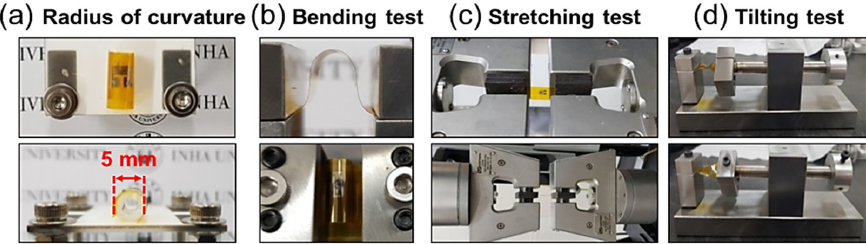
Figure 29. Digital photographs showing the ( a ) radius of curvature, ( b ) bending test, ( c ) stretching tests, and ( d ) tilting test. Reproduced from [107] with the permission of Elsevier.